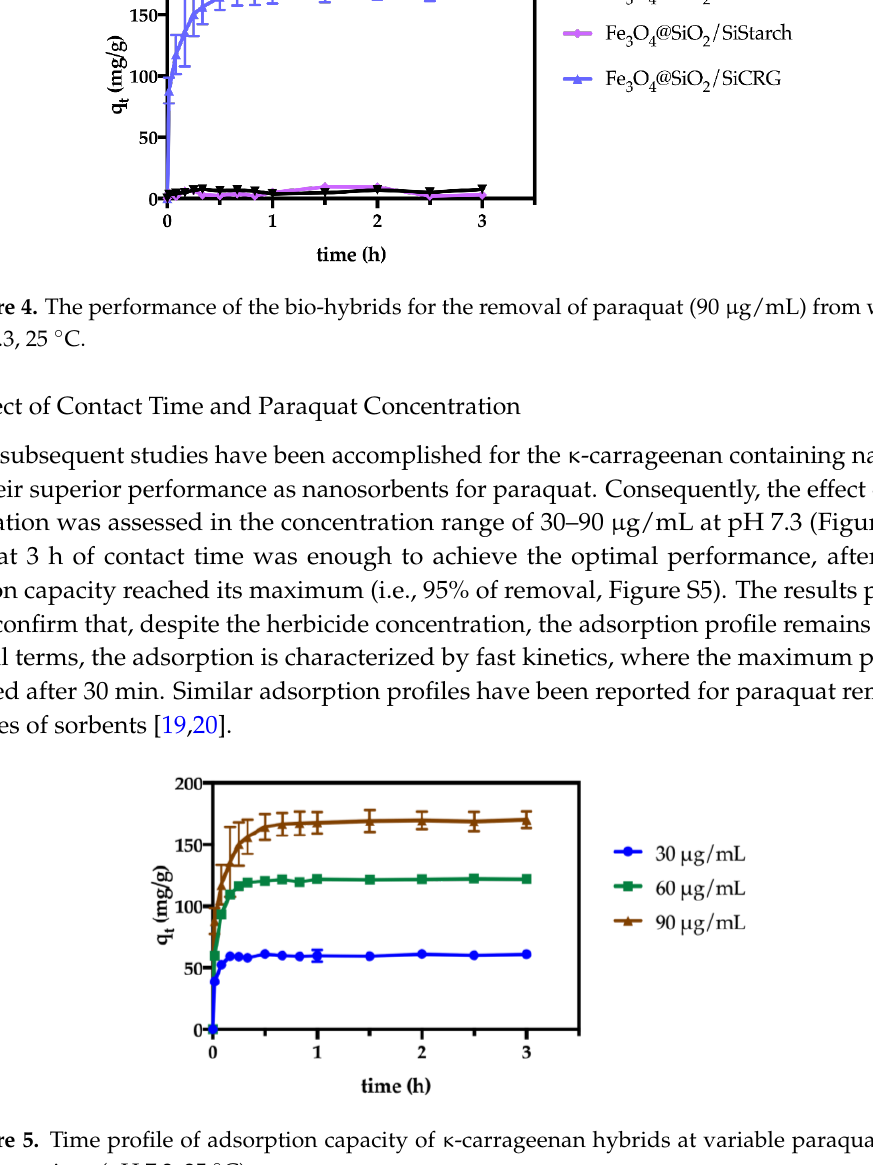
1st and 2nd order kinetic equations and the Elovich kinetic model, for an initial paraquat concentration of 90 μg/mL.